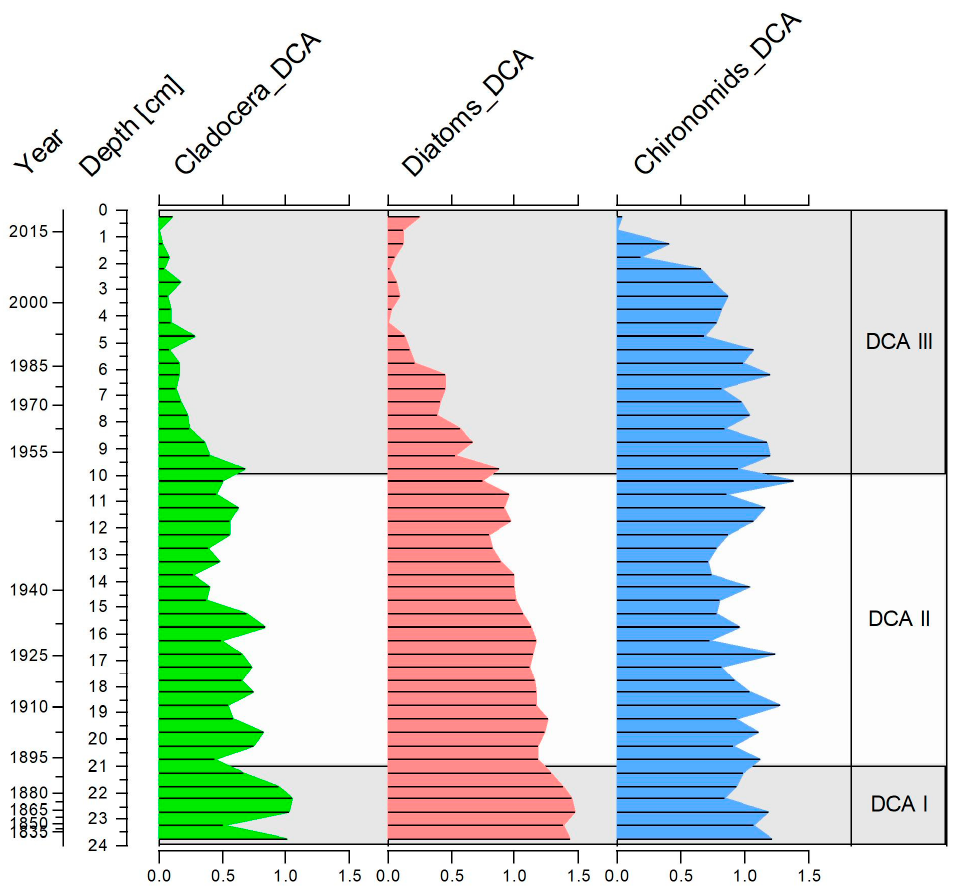
Figure 7. Comparison of the full community response of ■ cladocerans, ■ diatoms, and ■ chirono- mids, expressed as DCA 1 st axis scores.